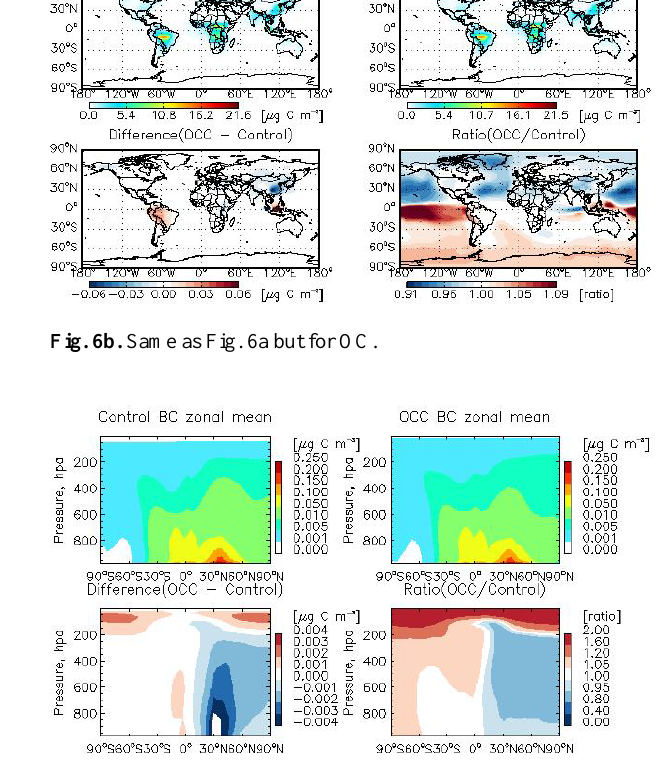
Fig. 6c. Same as Fig. 6a but for zonal